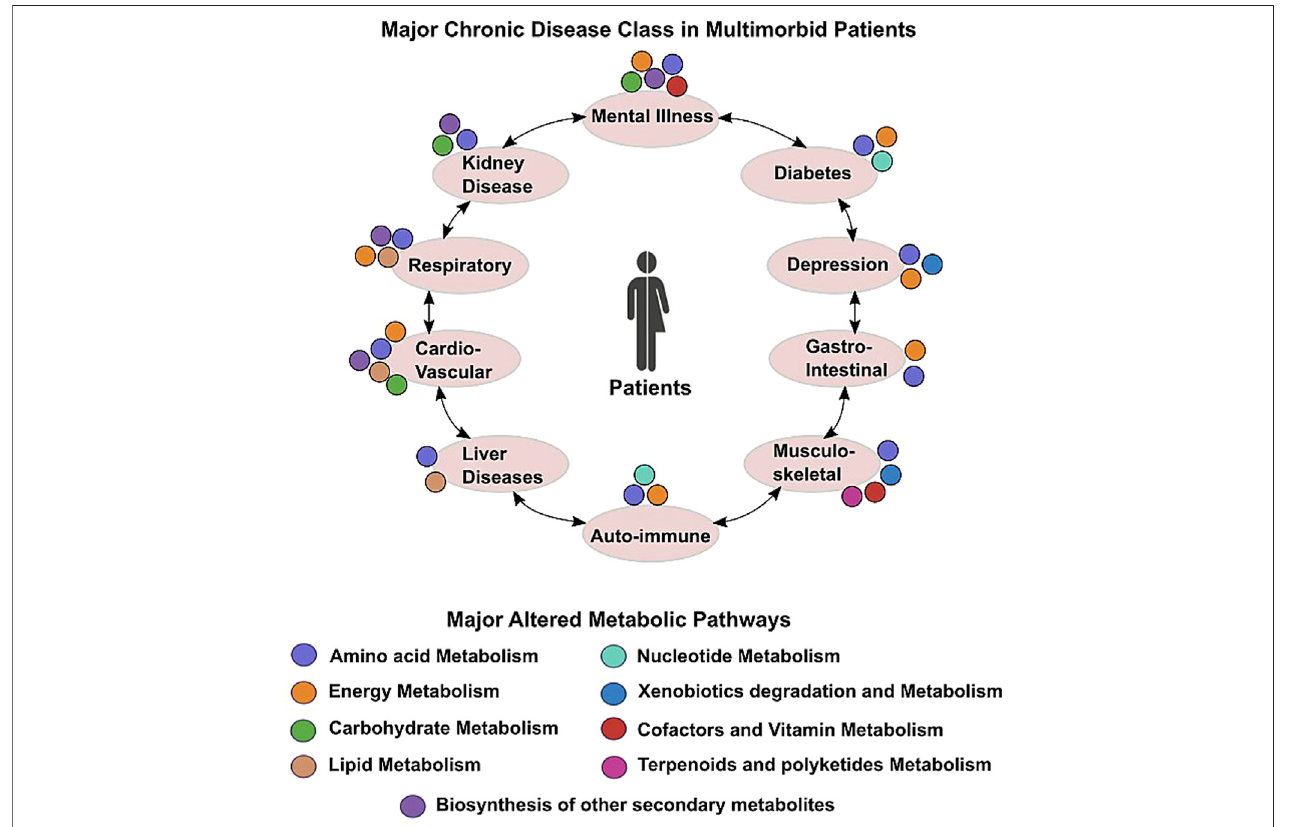
FIGURE 1 | Scheme depicting altered metabolic commonalities in major chronic conditions found in multimorbid